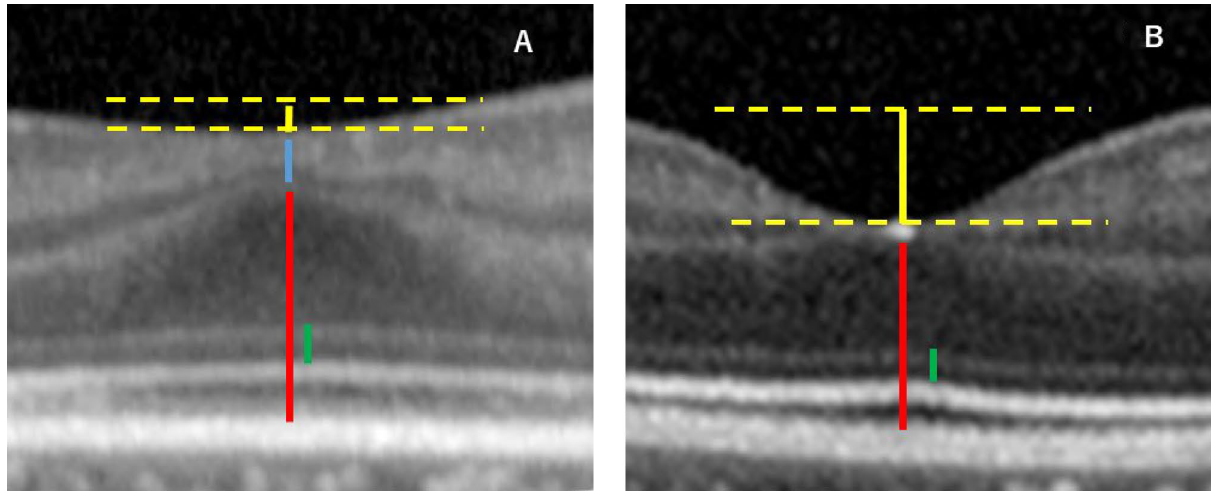
Figure 1. ( A ) Optical coherence tomography (OCT) images of a representative patient with retinopathy of prematurity (ROP) who underwent laser treatment. The foveal depression is shallow, at 22.5 µm in the OCT images, and IRL of the fovea is preserved (Fig. 1A). The inner retinal layer (blue line) at the fovea is still present. The foveal thickness (inner retinal layer and outer retinal layer, i.e., blue and red line, respectively) is 239 µm, the IS and OS lengths are 50 and 40 µm, respectively. Yellow line: foveal depression; blue line: inner retinal layer; red line: outer retinal layer; green line: IS length. ( B ) OCT image of a representative eye from the spontaneously regressed ROP group. The foveal depression is 108.5 µm in the OCT images (Fig. 1B). IRL of the fovea is not detected and the foveal thickness (red line, outer retinal layer) is 237 µm. IS length is 44 µm and OS length is 43 µm. Yellow line: foveal depression, red line: outer retinal layer, green line: IS